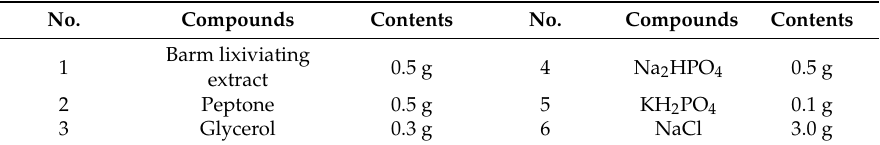
Table 1. Constituents of culture medium for P. phosphoreum